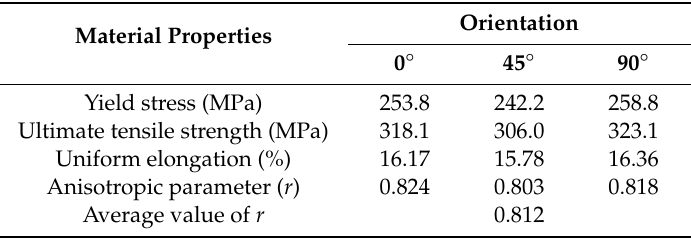
Table 1. Uniaxial tensile properties of 6016-T4 aluminum alloy in different orientations.